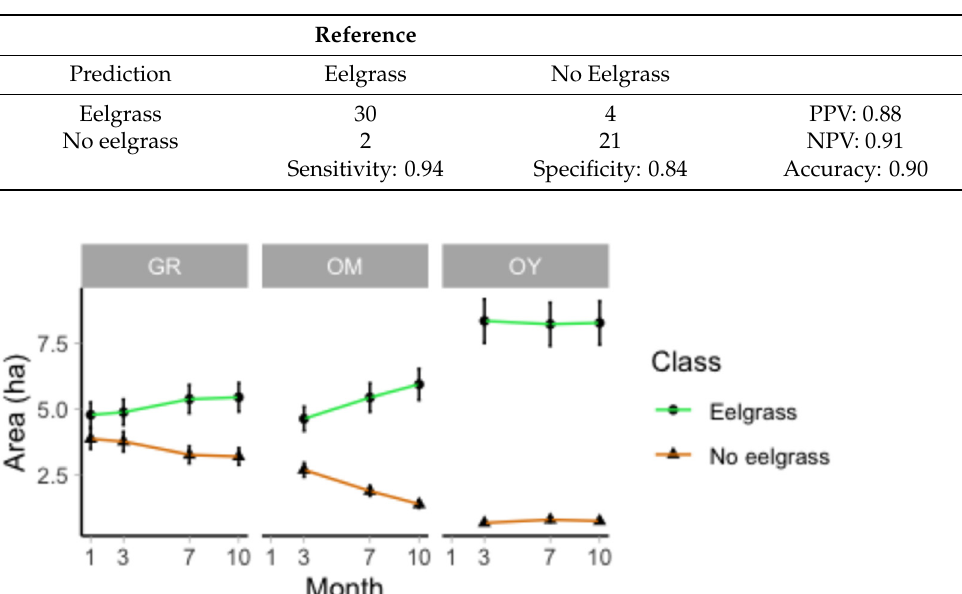
Table 3. Accuracy metrics for SVM classifications of multispectral satellite imagery. Eelgrass cover classification accuracy was tested for a binary classifier, using UAV-derived reference imagery.